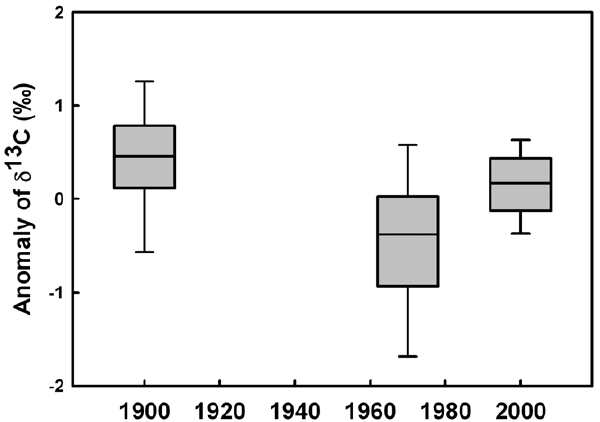
Figure 3. Long-term trend in anomalies of feather d 13 C values (corrected by Suess and phytoplankton fractionation effects). Anomalies were calculated independently for each subantarctic and subtropical penguin species (except the king penguin, see text for details). In the 1970s, d 13 C anomalies were significantly lower than in the 1900s and 2000s (p , 0.0001 and p , 0.001,